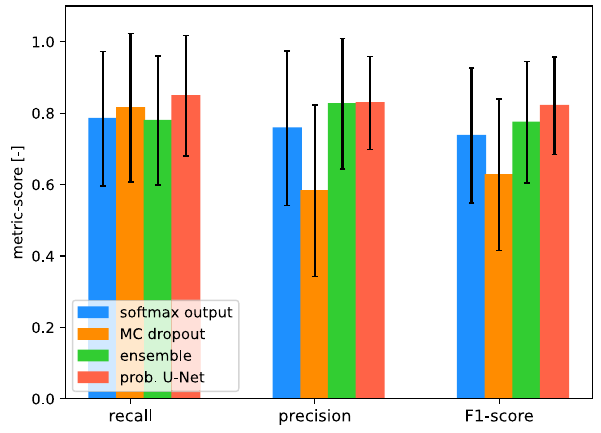
Fig. 11 Metric-scores for the dataset 2 with the complicated defect shapes